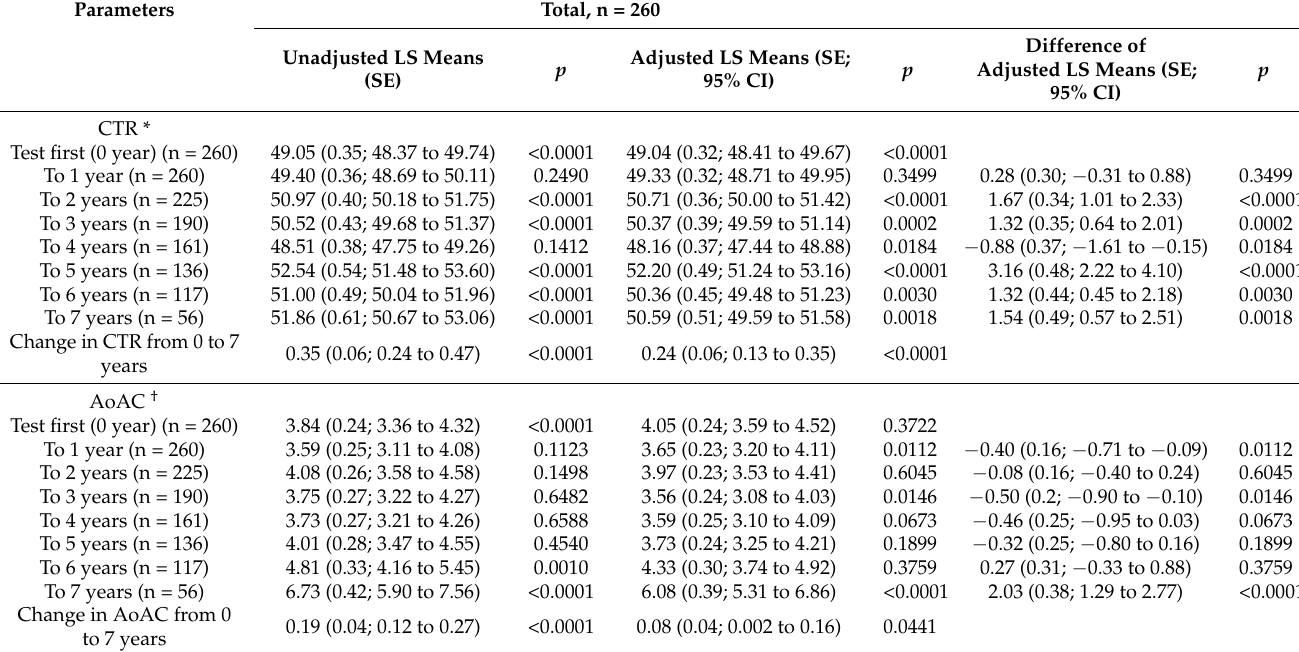
Figure 1. Mean CTR (blue) and AoAC (red) at each follow-up year in study patients (n = 260). Table 2 shows the time course of mean change in CTR or AoAC from baseline (0 year) to 7 years. In terms of CTR changes in HD patients, the CTR increased from 49.05% to